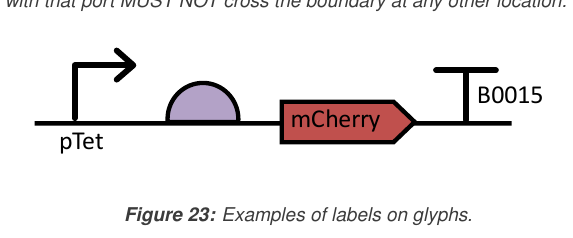
Figure 22: Examples of recommended and problematic module ports: (a) port on a black-box module, (b) ports connected to module internals via mappings, (c) boundary-crossing interaction passing through a port, (d) diagrams SHOULD NOT mix mappings and interactions on a give port, (e) ports MUST NOT be disconnected from their associated glyphs, and (f) if a port exists, interactions with that port MUST NOT cross the boundary at any other location.